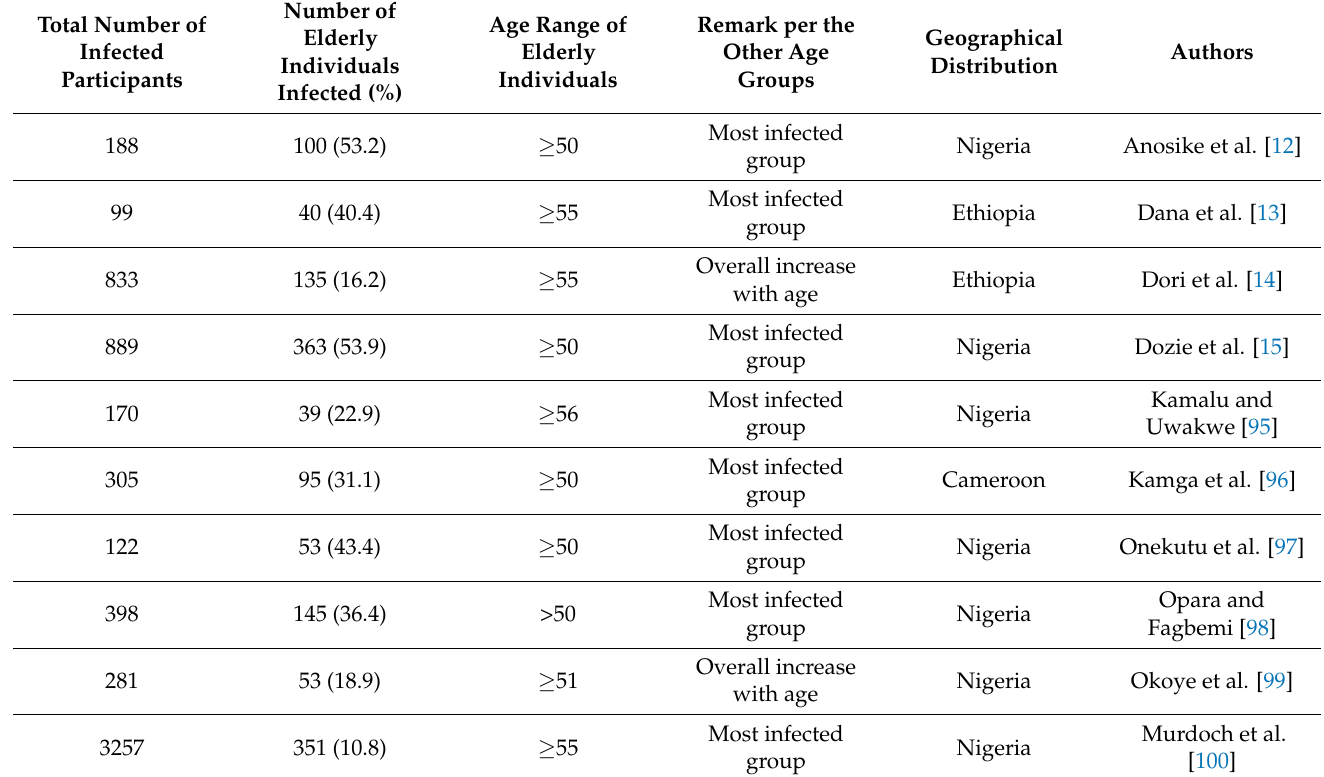
Table 1. Distribution of onchocerciasis in the older